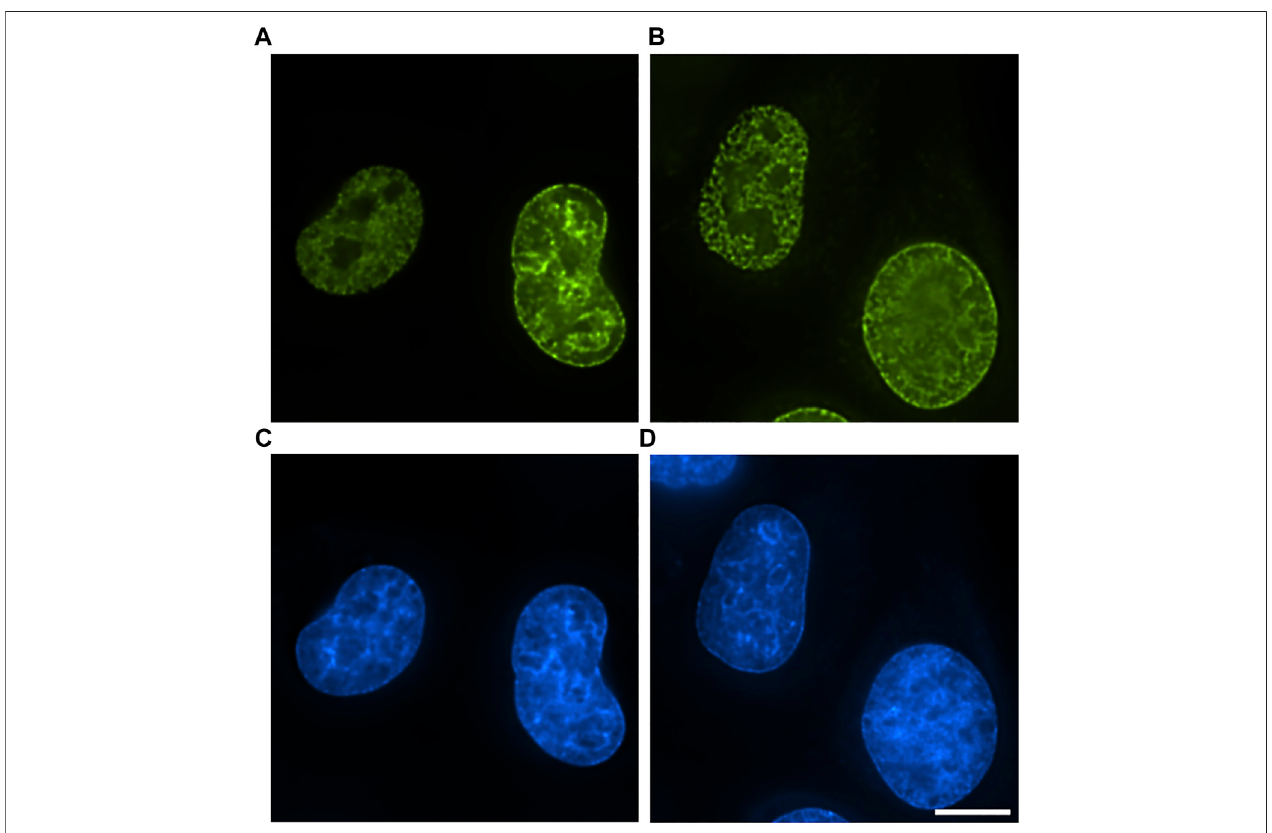
FIGURE 1 | Comparison of labeling ef fi ciency and probe penetration into EdU-labeled cells. (A) 10 min formaldehyde fi xation, detection with AlexaFluor-azide. (B) 1 h glutaraldehyde fi xation, detection with biotin-azide – streptavidin-AlexaFluor. Bar, 10 μ m. (C,D) DAPI staining. Bar 10 μ m.